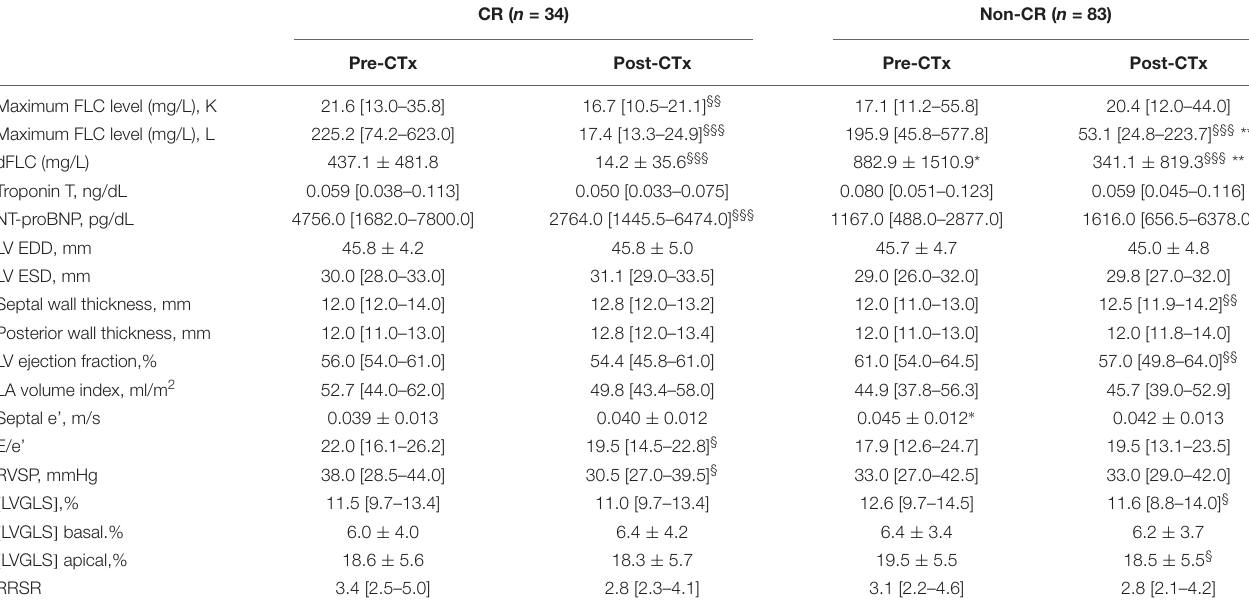
TABLE 2 | Pre- and post-chemotherapy (CTx) characteristics stratified by hematologic response.